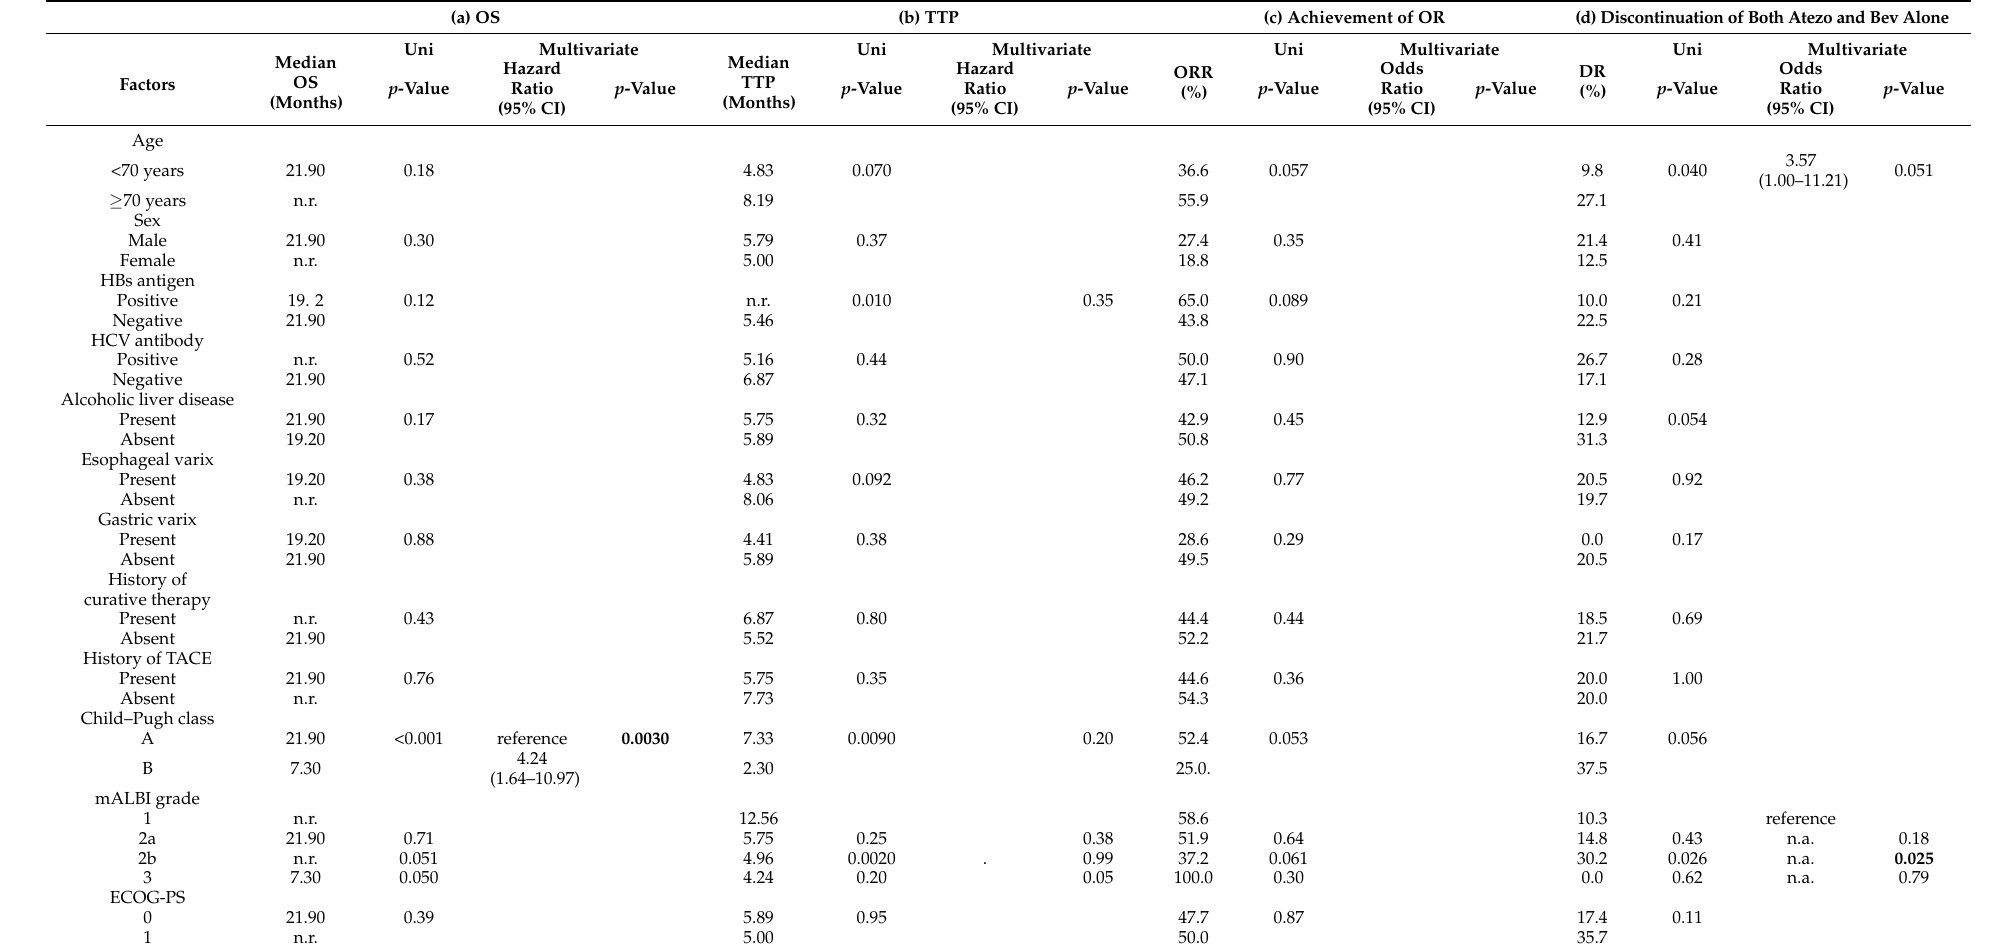
Table 5. Cox regression analyses of factors contributing to (a) OS and (b) TTP, and logistic regression analyses of factors contributing to (c) the achievement of OR and (d) experience of discontinuation of both Atezo and Bev alone ( n =